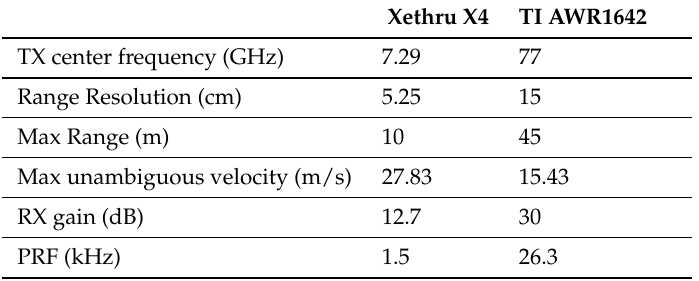
Table 1. Specifications for XeThru X4 C-band and TI AWR1642 W-band radars.